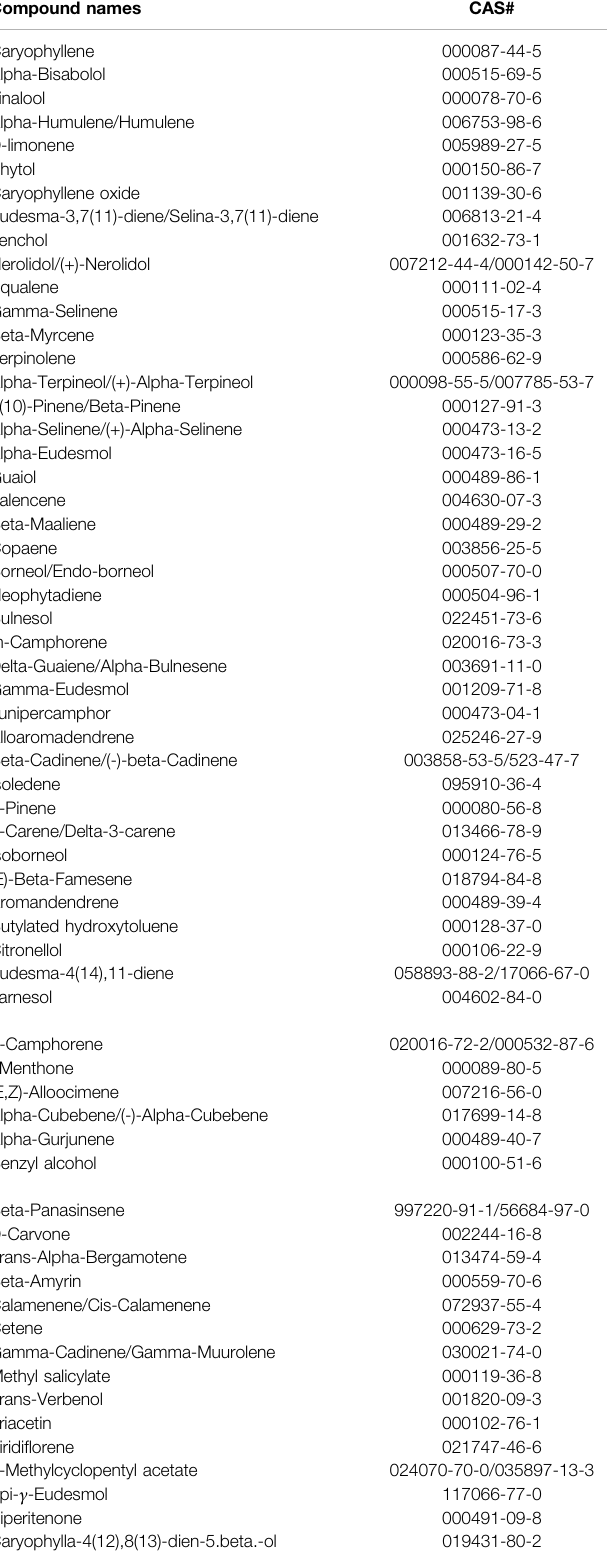
TABLE 2 | Terpenes detected in vape liquid, vapor and aerosol